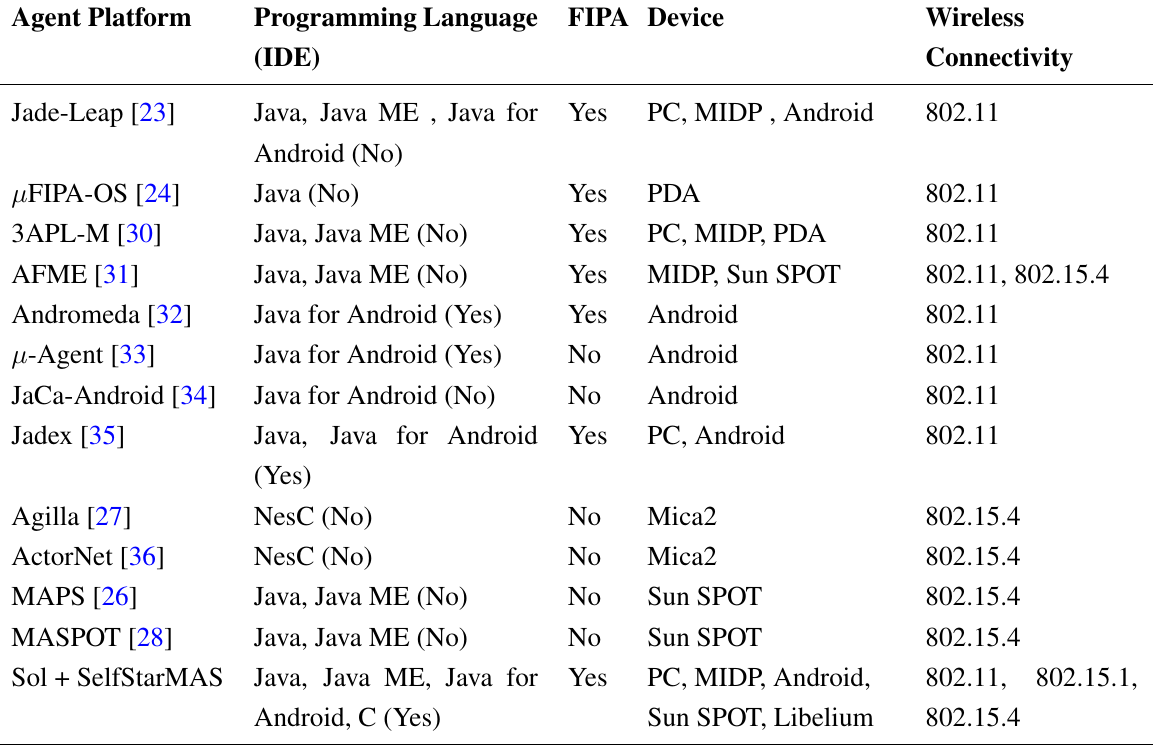
Table 2. Agent platforms for AmI